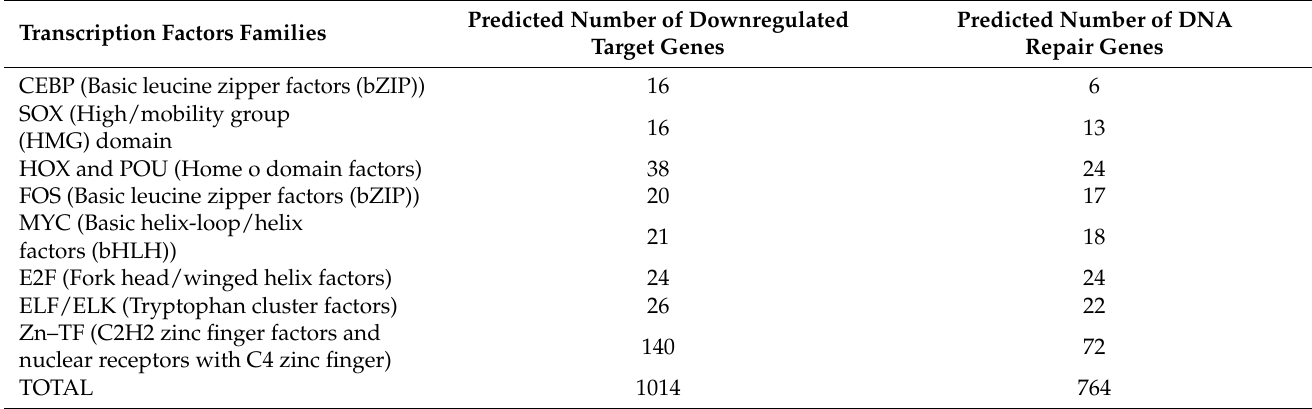
Table 4. In silico prediction of binding sites for different transcription